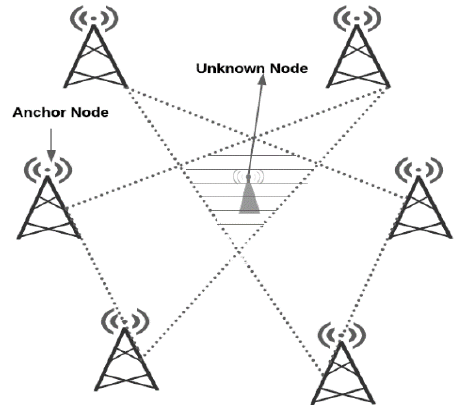
Figure 8. Approximate point-in-triangulation test. A comparison of range-based and range-free localization techniques based on evalua- tion metrics is given in Table Table 2. Comparison of Measurement Techniques.